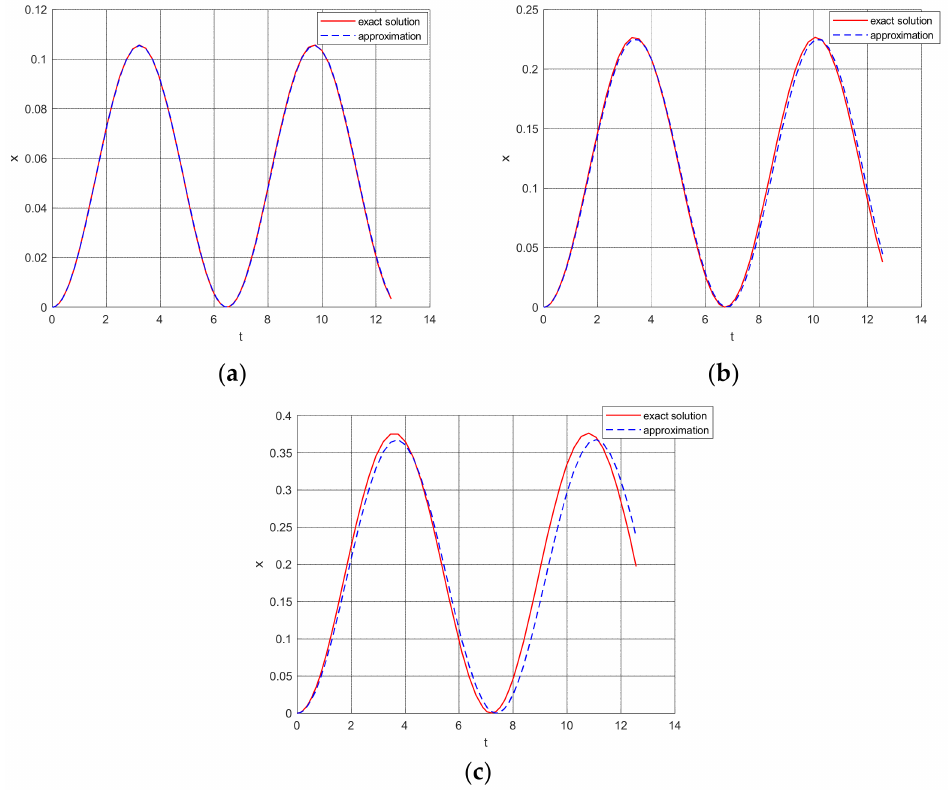
Figure 4. The MEMS oscillator with different values of b . ( a ) b = 0.05; ( b ) b = 0.10; and ( c ) b =